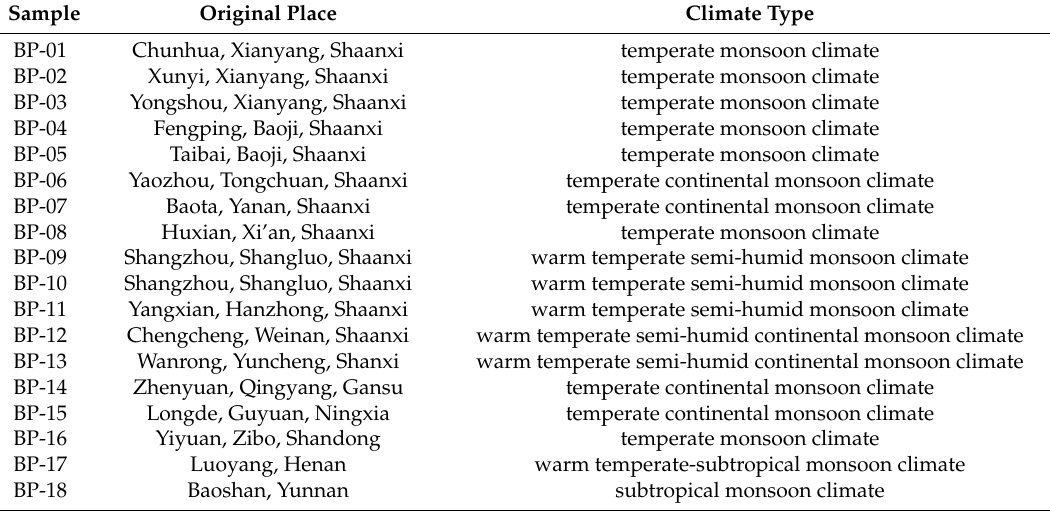
Table 2. The original places of 18 batches of Bolbostemma paniculatum bulbs and their corresponding climate